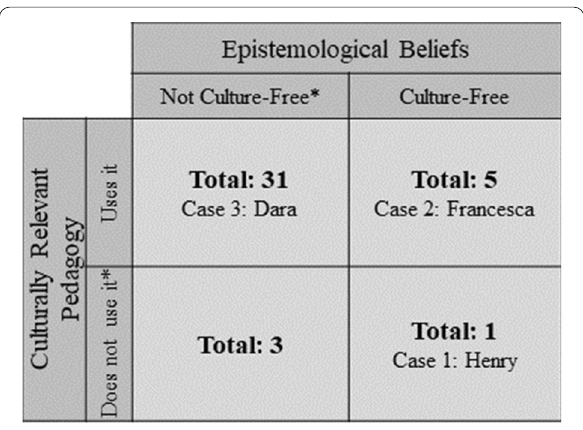
Fig. 2 How the three case studies cover a combination of epistemological beliefs and CRP usage. *We report that participants did not express using CRP and did not express culture-free beliefs. This is distinct from reporting that participants did not enact CRP and did not hold culture-free